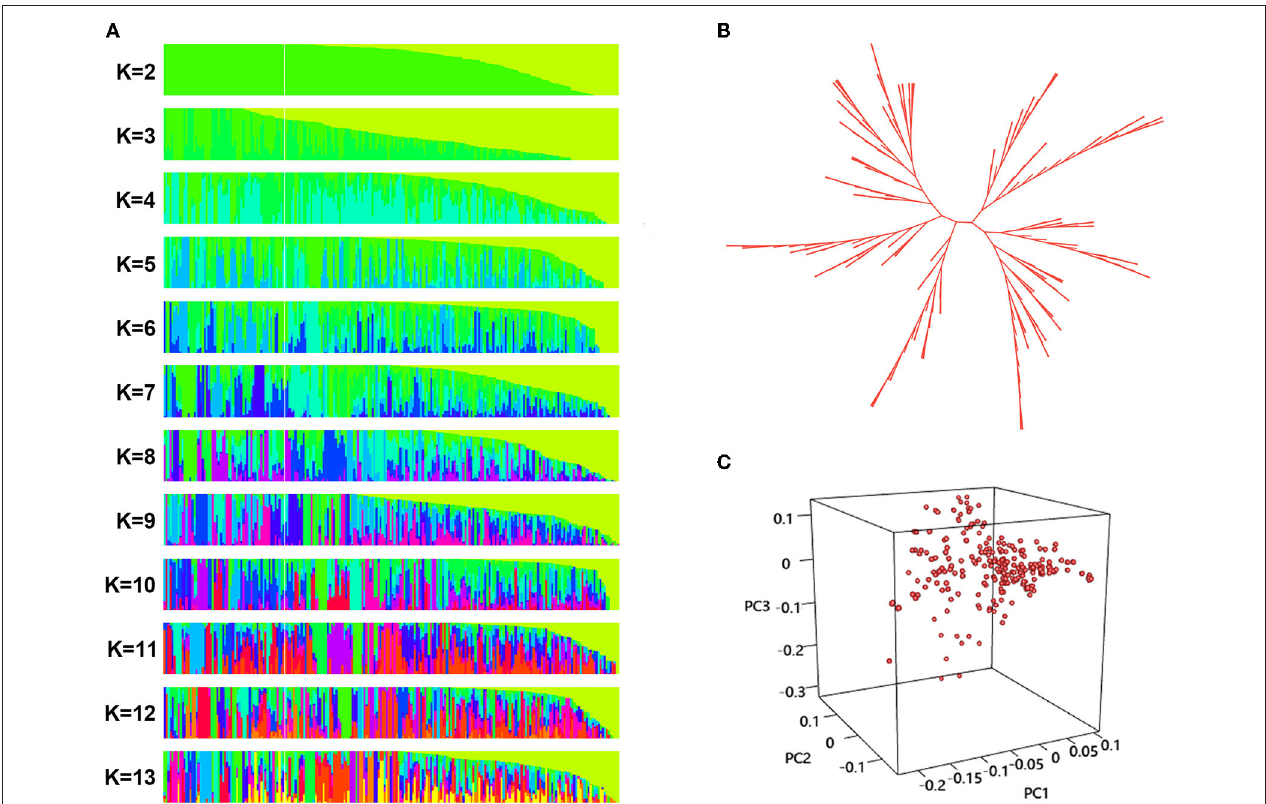
FIGURE 8 | Population structure analysis phylogenetic tree construction, and principal component analysis (PCA) of the 226 sunflower accessions. (A) Population structure of sunflower accessions estimated by ADMIXTURE, each row represents a given number of clusters ( K , K = 2–13), each vertical column represents one individual and each colored segment in each column represents the percentage of the individual in the population. (B) The unrooted neighbor-joining three a of 226 sunflower accessions. Each branch indicates a sample, and the length of the branches represents the genetic distance, (C) PCA scatter plots shows the distribution of 226 sunflower accessions defined by the eigenvectors of the first three principal components (PC). The three axes represent PC1, PC2, and PC3 respectively. Each dot represents a sample.